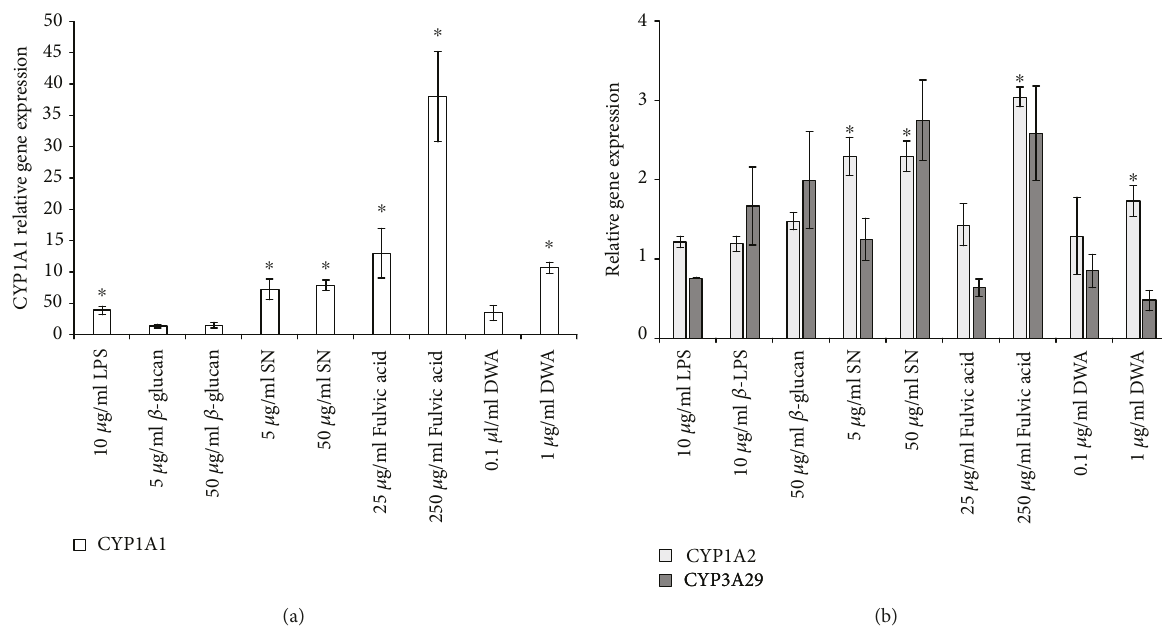
Figure 2: Relative expression of CYP1A1 (a) and CYP1A2 and CYP3A29 (b) genes in feed additive treated IPEC-J2 cells compared to untreated groups ( n = 6 /group, ∗ p < 0 05 ). Data are shown as means ± SEM. LPS: lipopolysaccharide; SN: sanguinarine-containing product; DWA: drinking water acidi fi er; CYP: cytochrome